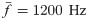
Examples of the stimuli.Waveform s(t) and instantaneous frequency f(t) of the sweep with f‾=1200Hz and Δf = −200 Hz and its corresponding sweep train.